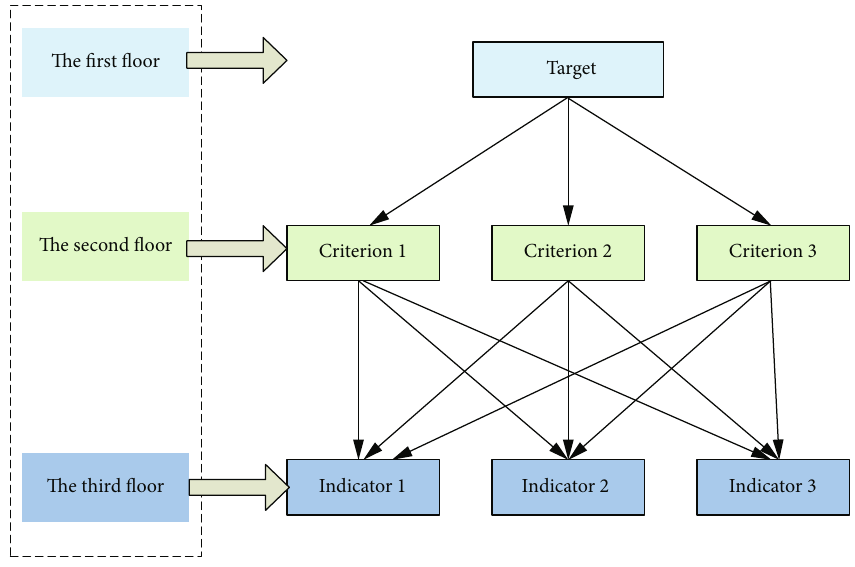
Figure 4: AHP structure